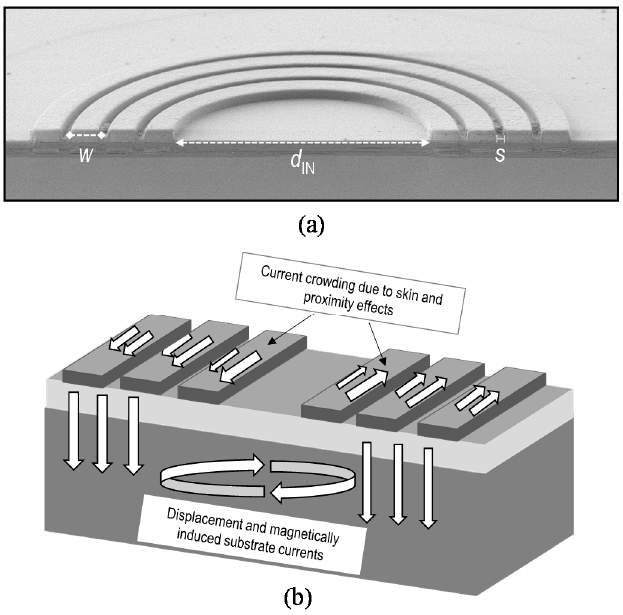
Figure 1. ( a ) SEM cross-section of a silicon-integrated spiral inductor; ( b ) simplified representation of main loss phenomena in silicon-integrated inductive components. Reprinted with permission from ref. [9] . Copyright 2020, IEEE .